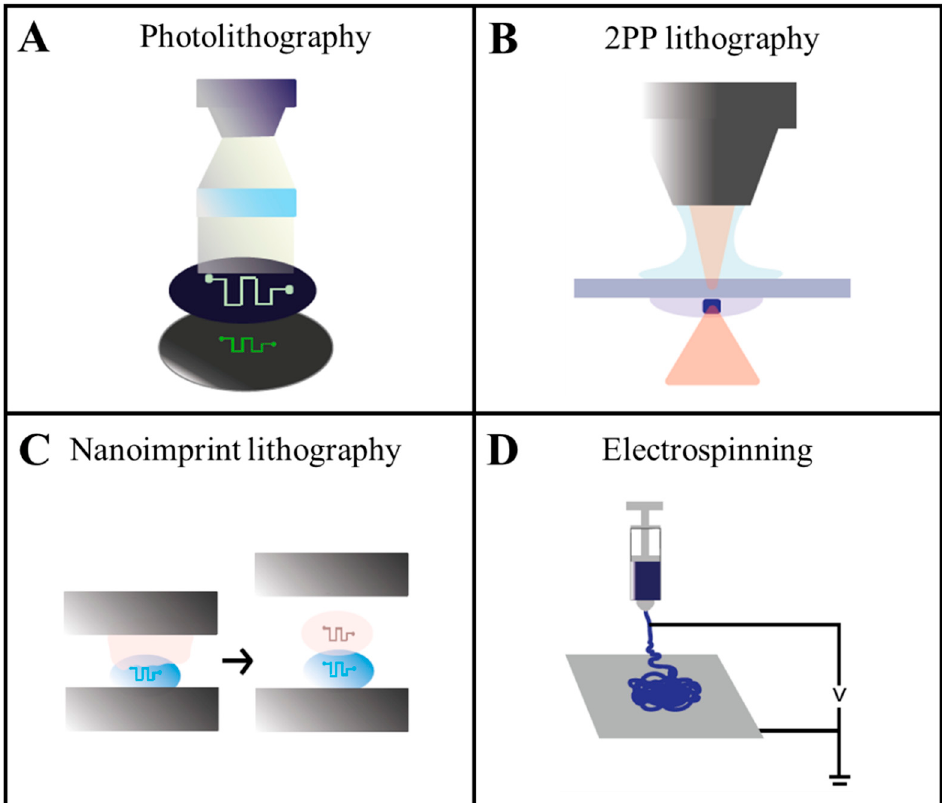
Figure 3. Examples of advanced fabrication tools that can be used for producing bio-instructive substrates for the culture of hCECs. ( A ) Photolithography for transferring a pattern into a photosensitive material. A photoresist is selectively exposed to UV light through a partially light-blocking photomask placed between the UV source and the resist; ( B ) 3D direct laser writing technique based on two-photon polymerization (2PP) lithography. This technique can generate 3D structures from photosensitive materials with resolutions <100 nm; ( C ) nanoimprint lithography. Surface features are transferred onto a polymer material through a mold (stamp) by means of heat or UV light; ( D ) electrospinning for producing continuous nanofibers. A high-voltage electric field is applied between a needle (connected to a polymeric solution reservoir) and a collector on which polymeric nanofibers are attracted.